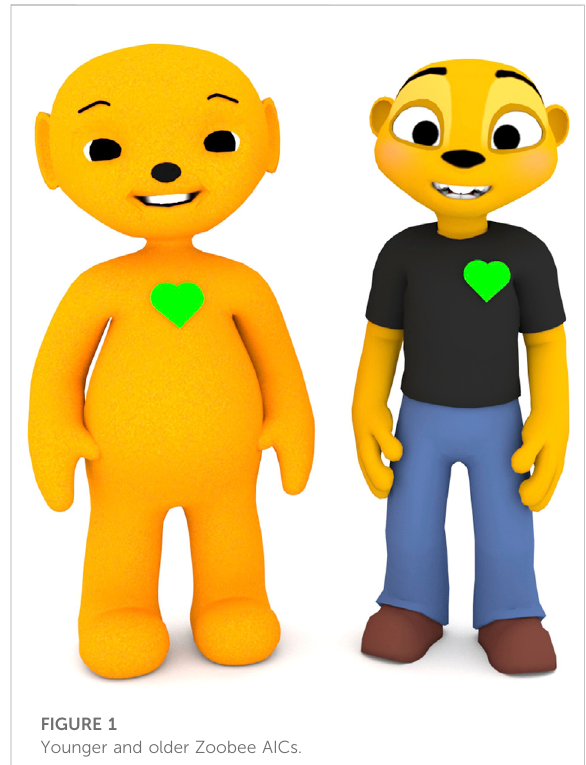
FIGURE 1 Younger and older Zoobee